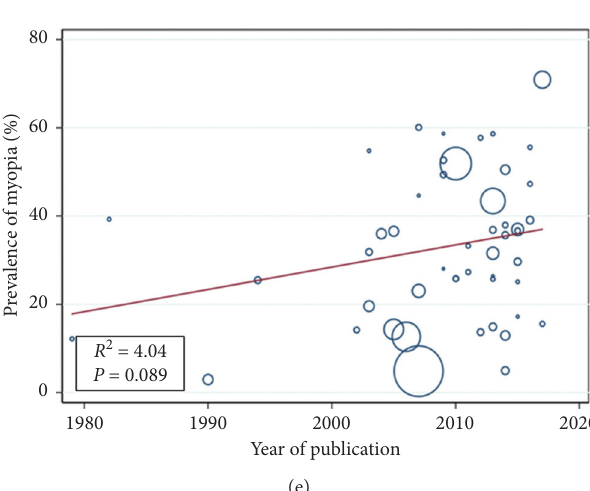
Figure 2: Metaregression plots showing the relationship between myopia prevalence and environmental factors: mean cumulative annual sunshine hours (a), mean annual temperature (b), population density (c), seasonal variation in sunshine hours (d), and year of publication of the paper (e) for all studies. The size of each circle is proportional to the weight (number of subjects) of the studies. The solid line indicates best fit regression